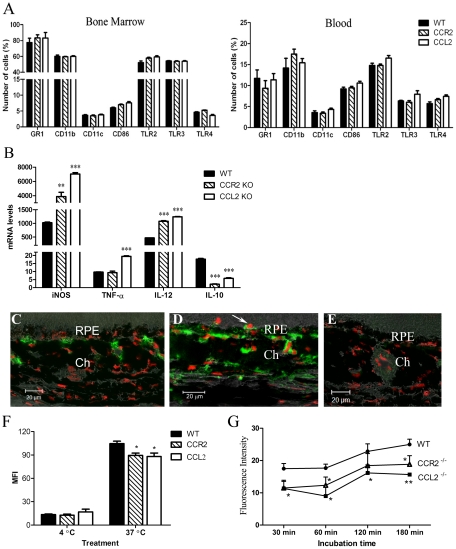
Phenotype and function of myeloid-derived cells in different strains of mice.A, Bone marrow and blood cells collected from different strains of mice were stained for different cell surface markers and analysed by flow cytometry. Mean ± SEM, N = 6. B, Cytokine gene expression in LPS stimulated BM-DMs of different strains of mice. Mean ± SEM, N = 3. *, P<0.05; **, P<0.01; compared to WT cells. Unpaired Student t test. Experiments were performed four times. C–D, Nitrotyrosine (green) and PI (red) staining in the eye of a 20-month old WT mouse (C) and a 20-month old CCL2 KO mouse (D). E, isotype control staining. Ch, choroid; RPE, retinal pigment epithelium. F, Endocytosis of BM-DMs using dextran method (see Materials & Methods). MFI, mean fluorescence intensity. G, Phagocytosis of E. coli by BM-DMs (see Materials & Methods). Mean ± SEM, N = 3. *, P<0.05, **, P<0.01 compared to WT cells of the same time point. Dunnett Multiple comparison test. Experiments were performed twice.